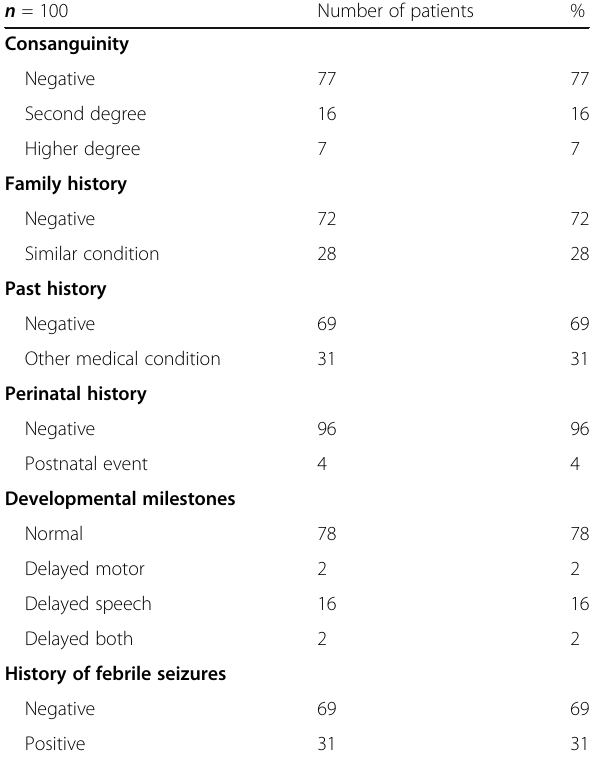
Table 1 Distribution of different history items